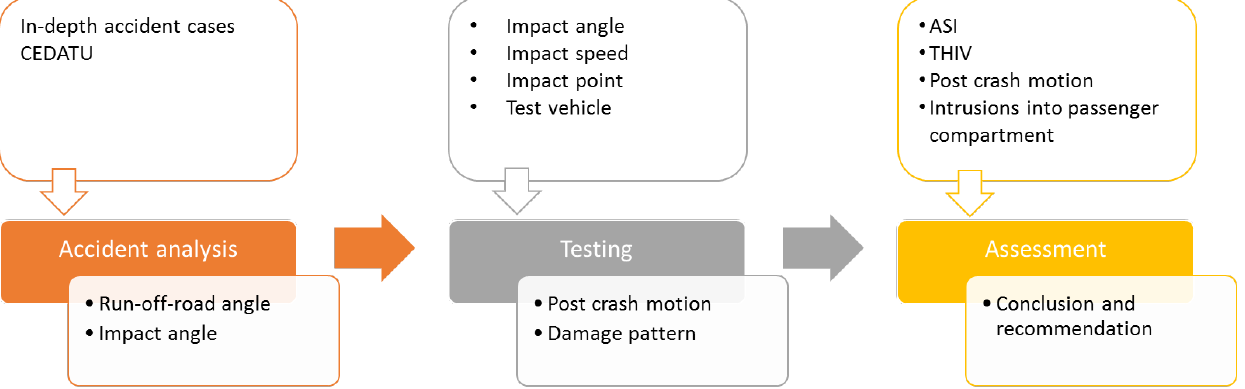
Figure 5. Flow chart of the Methodology.